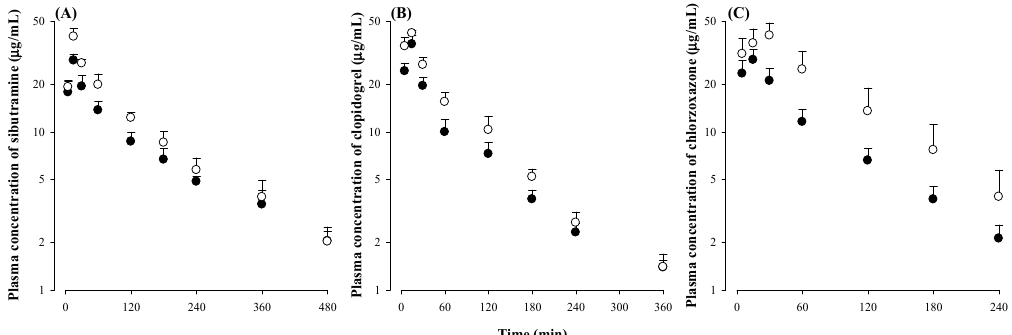
Figure 5. Plasma concentrations of sibutramine ( A ); clopidogrel ( B ); or chlorzoxazone ( C ) after its oral administration with vehicle ( ● ) and sauchinone ( ○ ). The number of mice were five for each group. Table 3. Pharmacokinetic parameters of sibutramine, clopidogrel, or chlorzoxazone after its oral administration with or without sauchinone.